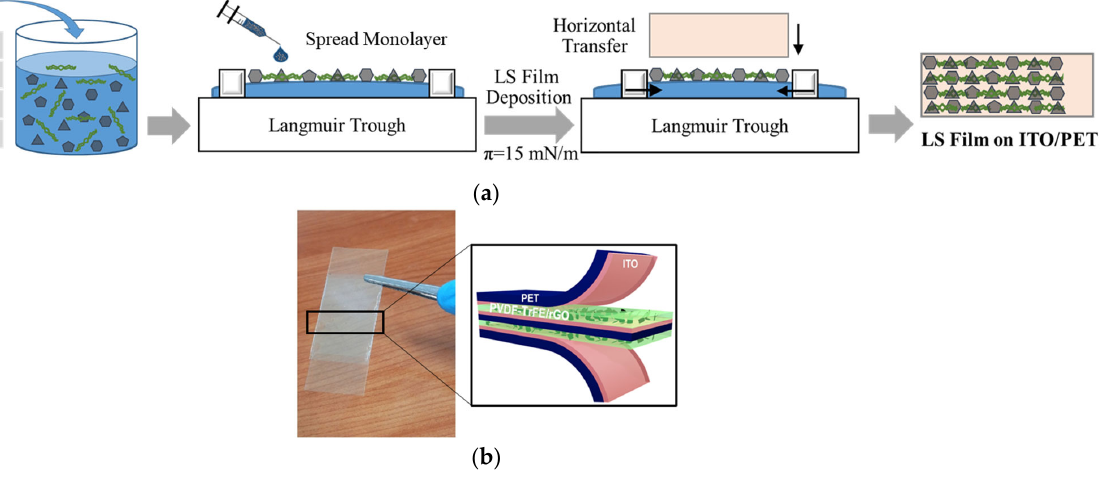
Figure 1. ( a ) Thin ‐ film preparation procedure; ( b ) picture of fabricated PENG with a sandwich structure.